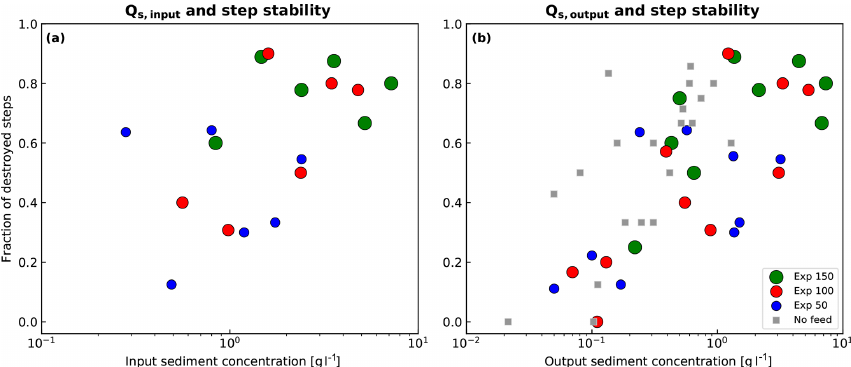
Figure 12. Fraction of steps that were destroyed in each run as a function of the logarithm of sediment concentration of (a) sediment input and (b) sediment yield. Feed experiments are shown with circles (whose size is proportional to the feed rate), and no-feed experiments are shown with